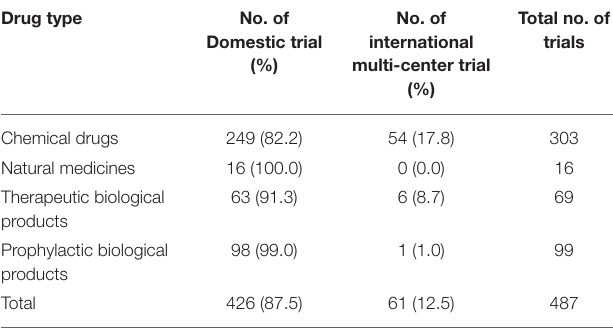
TABLE 4 | Scope of trials for different drug types.